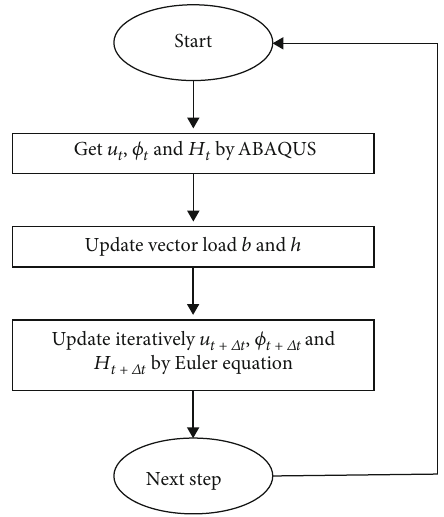
Figure 2: The process for solving phase fi eld model.